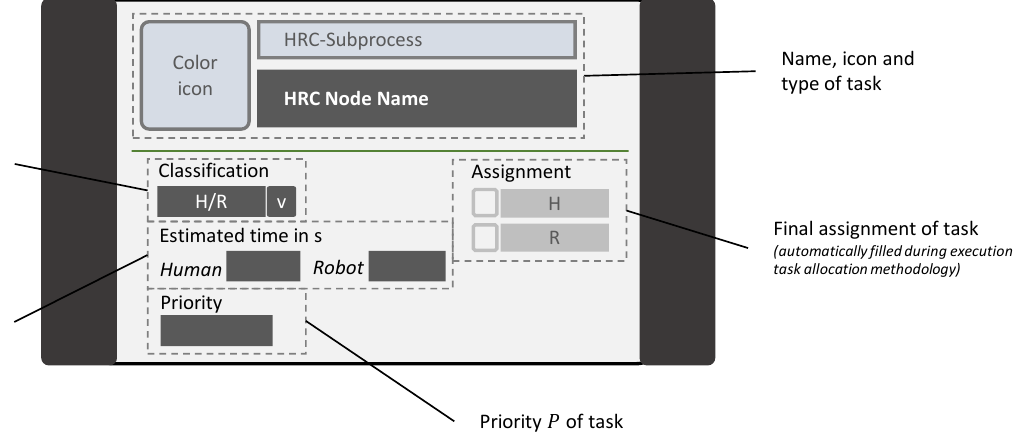
Figure 5. Conceptual representation of function blocks, which include sub-processes for the execution of the tasks by humans or robots (HRC nodes).